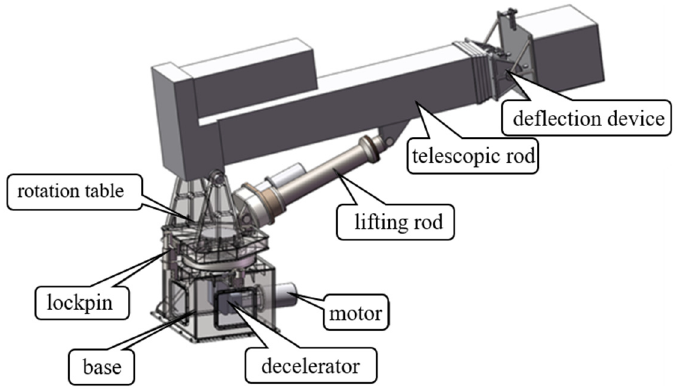
Figure 1. The DMDS has an attitude adjustment structure in different directions to adapt to the different shapes of the tunnel section.